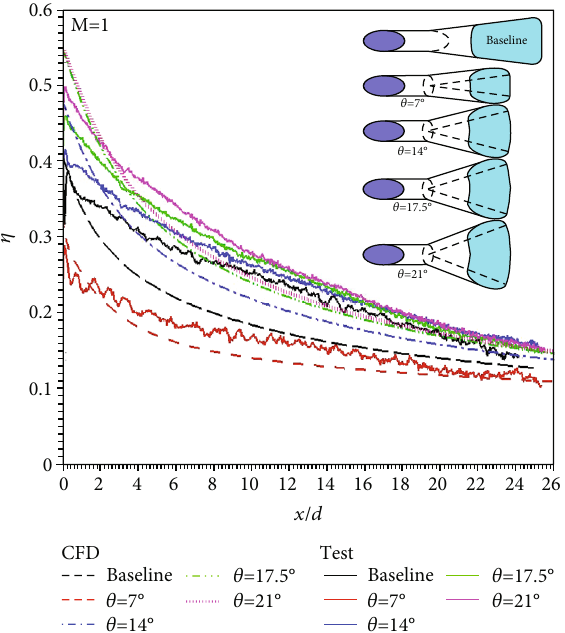
Figure 24: Streamwise variation of test and CFD fi lm e ff ectiveness (spanwise-averaged at each point) for the blowing ratio of 1.